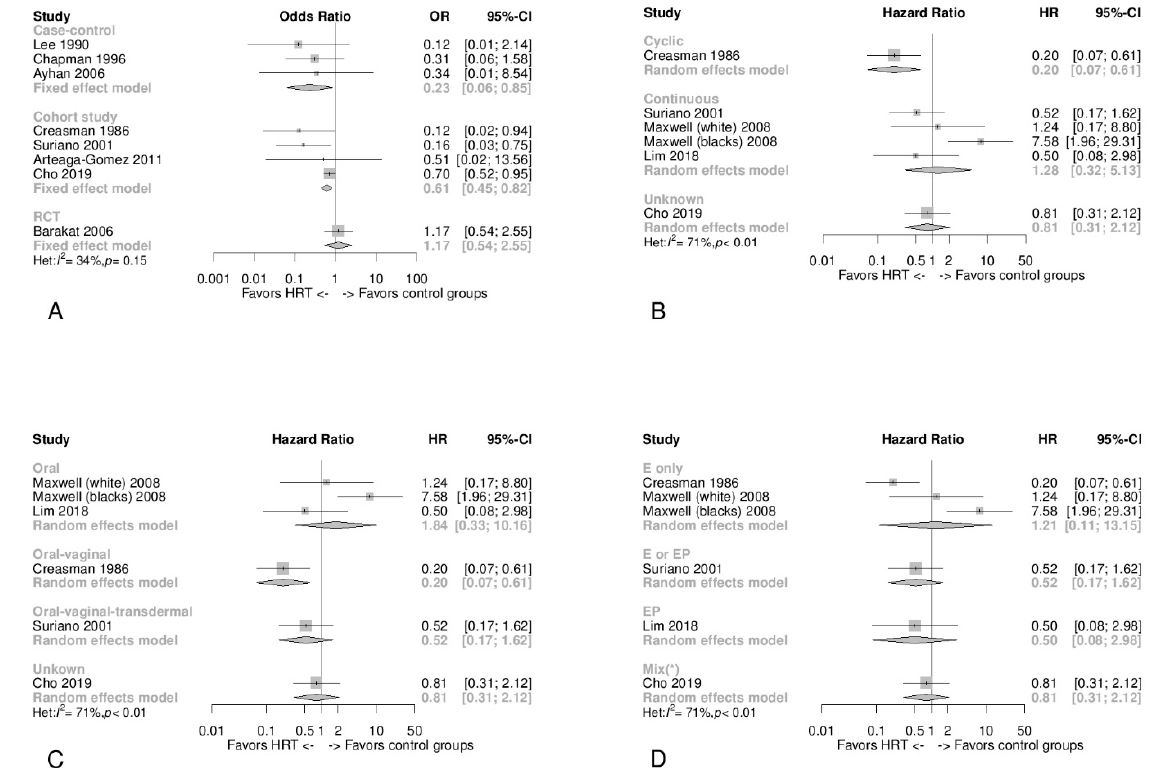
Figure 3. Panel ( A ) Forest plot of odds ratio (OR) meta-analysis for recurrence risk showing a pooled fixed-effect model subgroup analysis by type of study (in this analysis, Lim and coworkers were excluded due to a potential overlap with Cho and coworkers). Panel ( B ) Forest plot of hazard ratio (HR) meta-analysis for disease-free survival/recurrence risk showing a pooled random effect model subgroup analysis by the timing of HT administration (cyclic vs. continuous). Panel ( C ) Forest plot of hazard ratio (HR) meta-analysis for disease-free survival/recurrence risk showing a pooled random effect model subgroup analysis by the method of HT administration. Panel ( D ) Forest plot of hazard ratio (HR) meta-analysis for disease-free survival/recurrence risk showing a pooled random effect model subgroup analysis by type of HT ((*) the mixed subgroup includes patients treated with tibolone).